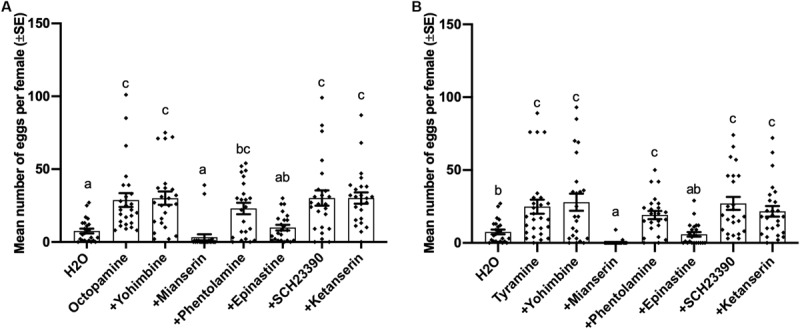
Effects of different antagonists on octopamine-inducing and tyramine-inducing oviposition by virgin females of Plutella xylostella. Number of eggs laid by virgin females at 1 day after injection with 0.3 μL of different mixed solutions containing 0.02 mol/L different antagonists and 0.1 mol/L octopamine (A) or tyramine (B) and Milli-Q water as a control (23 ≤ n ≤ 27). Individual data is displayed with dots. Different letters above columns mean significant differences between treatments (p < 0.05, ANOVA and Tamhane’s T2).